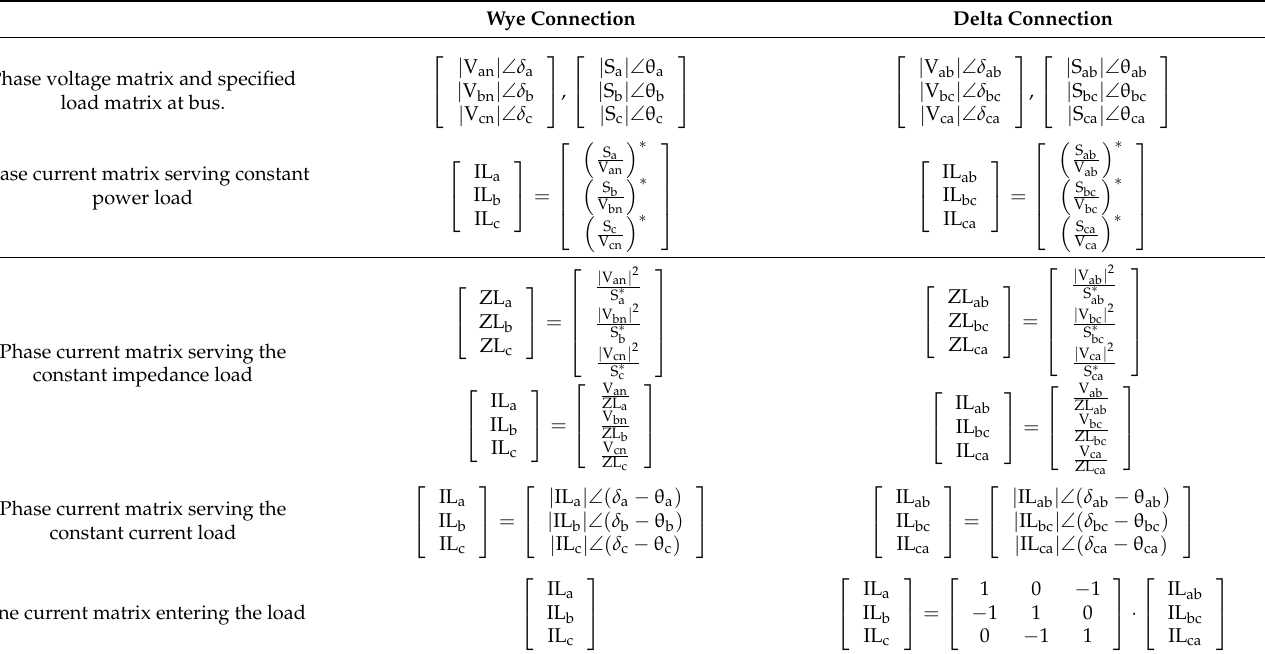
Table 1. Load modelling.